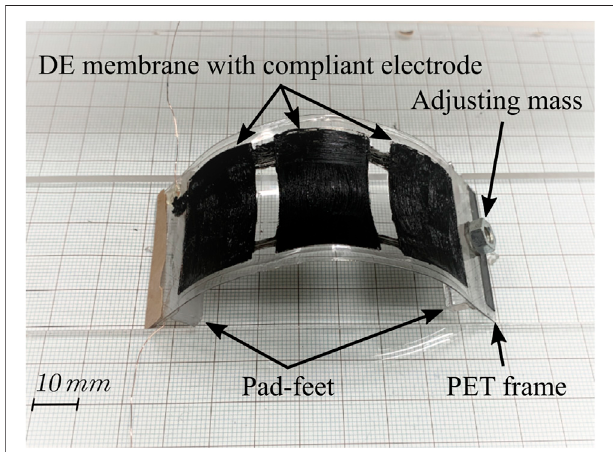
FIGURE 1 | Proposed soft inchworm crawler prototype.